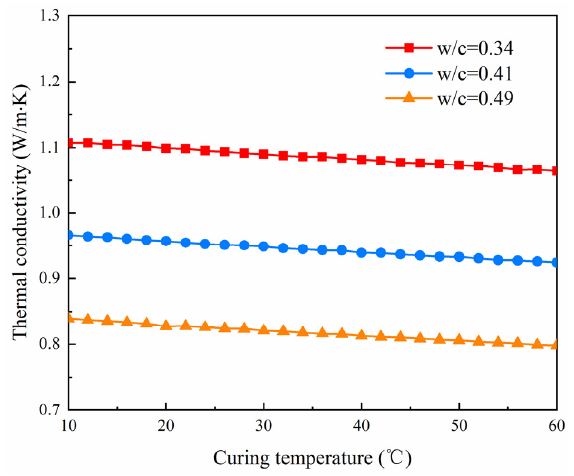
Figure 9. Evolution of the thermal conductivity against curing temperature at dry state.